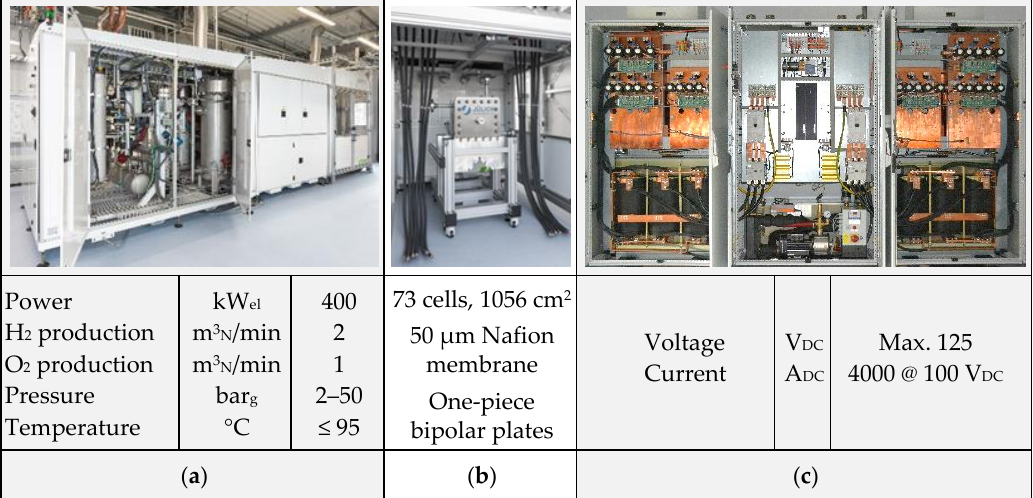
Figure 11. Electrolysis facility with first stack in the pilot plant; ( a ): PEM electrolysis test facility (GREENLIGHT); ( b ): 400 kW PEM stack (IEK-14, FZJ); ( c ): IGBT-based AC/DC converter (AIXCOM).